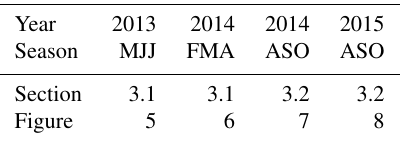
Table 2. Overview of the four haze events studied in detail